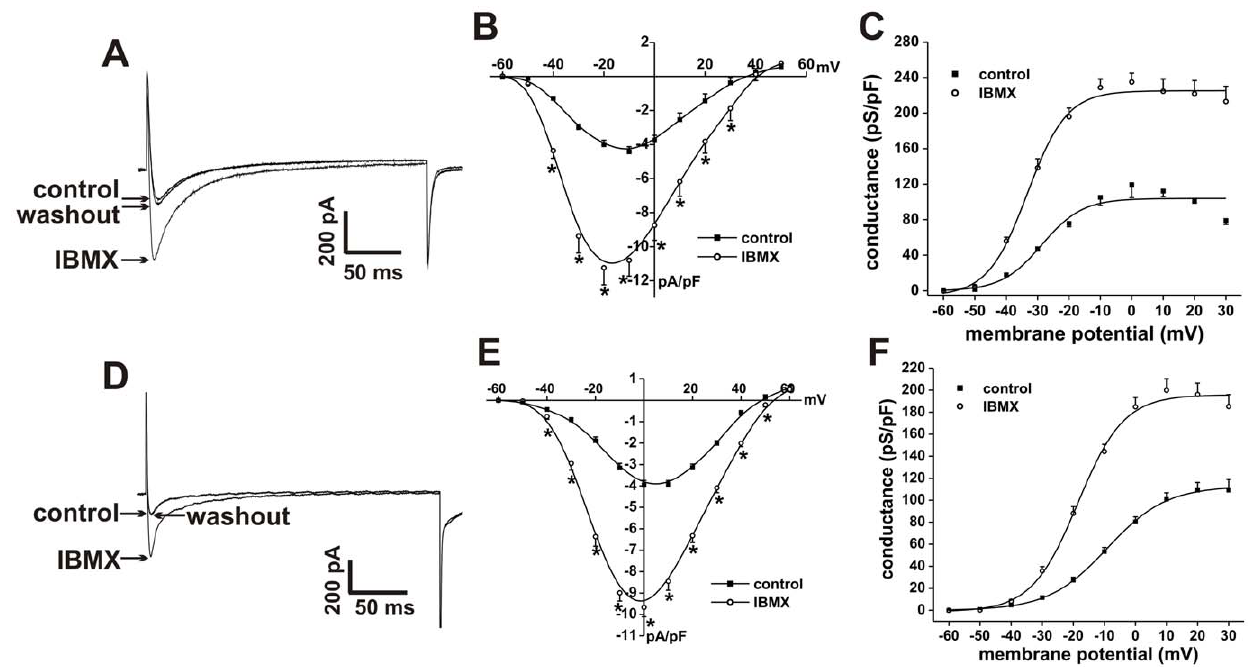
Figure 6. Effects of IBMX on L-type Ca 2 + current in SAN and right atrial myocytes. A. Representative I Ca,L recordings in SAN myocytes in control conditions, in the presence of IBMX (100 m M) and following IBMX washout. B. Summary I–V relationships for the effects of IBMX on SAN myocyte I Ca,L . C. Summary I Ca,L conductance density plots for the effects of IBMX in SAN myocytes. D. Representative I Ca,L recordings in right atrial myocytes in control conditions, in the presence of IBMX (100 m M), and following IBMX washout. E. Summary I–V relationships for the effects of IBMX on right atrial myocyte I Ca,L . F. Summary I Ca,L conductance density plots for the effects of IBMX in right atrial myocytes. Summary data are means 6 SEM; n =8 SAN myocytes and 12 right atrial myocytes; * P , 0.05 vs. control by paired Student’s t